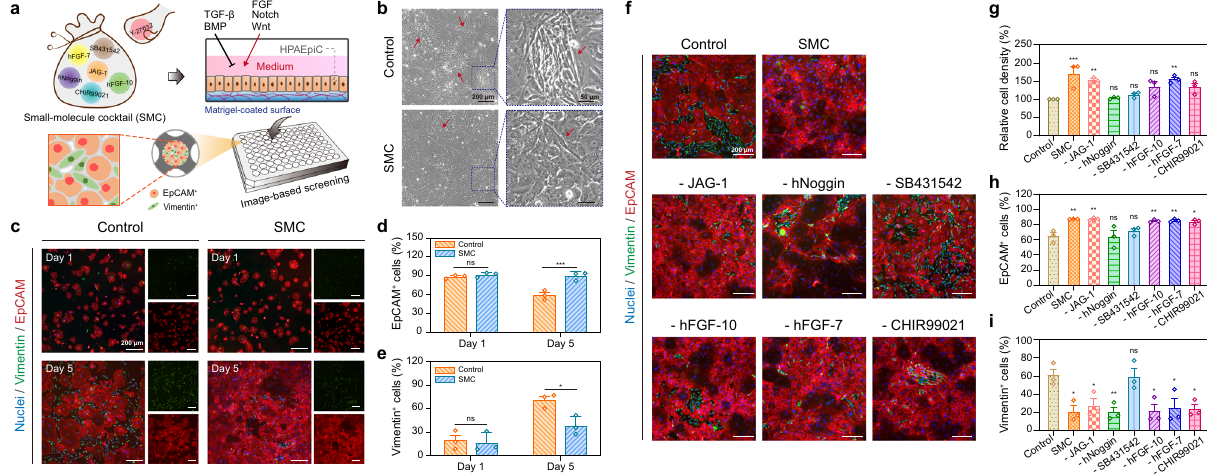
Fig. 1 Development of customized HPAEpiC cell culture medium. a Schematic of screening process for HPAEpiC culture medium development. HPAEpiCs were cultured with various small molecules to mediate growth; a high-content imaging system was used to identify the EpCAM + and Vimentin + cell populations. b Representative images of HPAEpiCs cultured with control and SMC media. The arrowhead indicates elongated spindle-shaped cells (mesenchymal-like cells). c The HPAEpiCs were stained with Vimentin (green) and EpCAM (red) antibodies, which are speci fi c markers for mesenchymal and epithelial cells, respectively, after 1 and 5 days of culturing. Quanti fi cation of EpCAM + ( d ) and Vimentin + ( e ) cell populations. The SMC medium supports epithelial cell phenotype maintenance after 5 days of culturing. f The HPAEpiCs were stained with Vimentin (green) and EpCAM (red) antibodies following culturing in various small-molecule media for 5 days. g Cell-density quanti fi cation after 5 days of culturing. The SMC, -JAG-1, and -hFGF-7 media have higher cell growth density than the control medium. Quanti fi cation of EpCAM + ( h ) and Vimentin + ( i ) cell populations after 5 days of culturing. SB431542 plays a crucial role in preventing epithelial to mesenchymal transition. Data and error bars represent mean ± SEM from three separate experiments. Two-way ( c , d ) and one-way ANOVA tests ( g – i ). * p < 0.05; ** p < 0.01; *** p < 0.001; ns non-signi fi